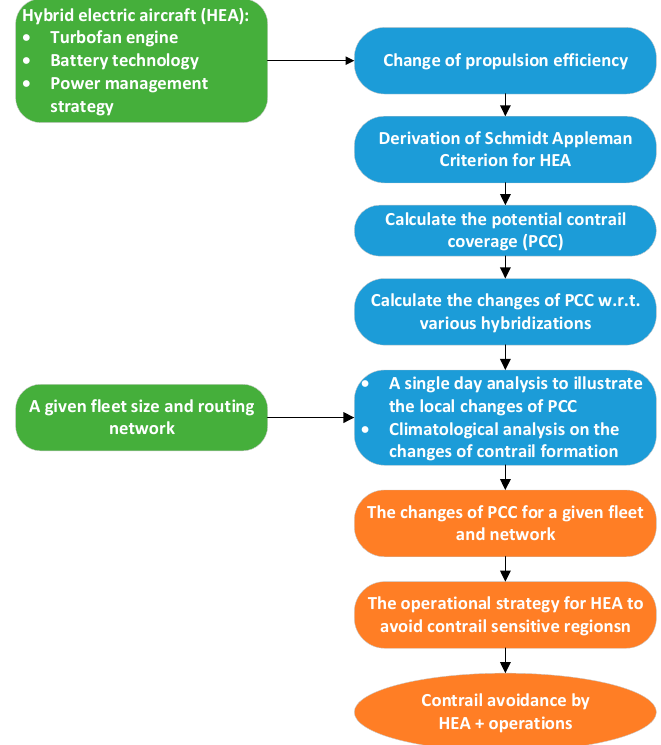
Figure 4. A schematic of a research methodology map to investigate the potentials of flying a hybrid-electric aircraft (HEA) for contrail avoidance.